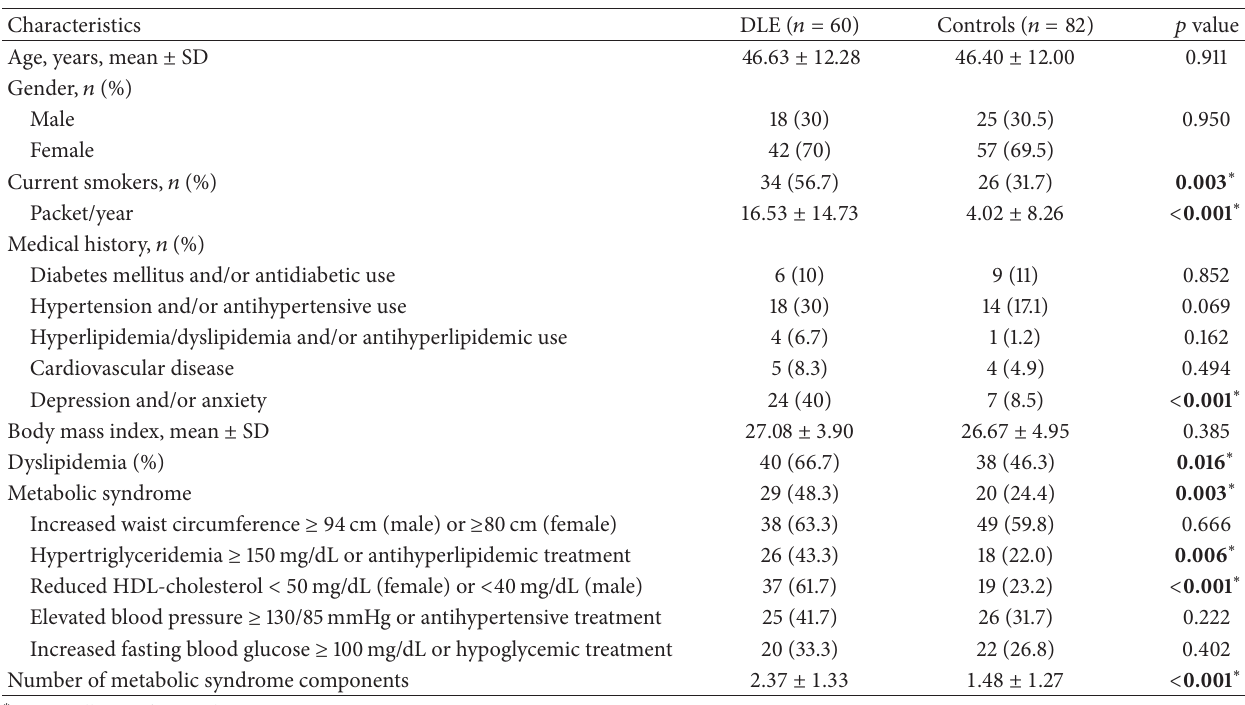
Table 1: Comparison of sociodemographic features, medical history findings, and metabolic syndrome components in study subjects.